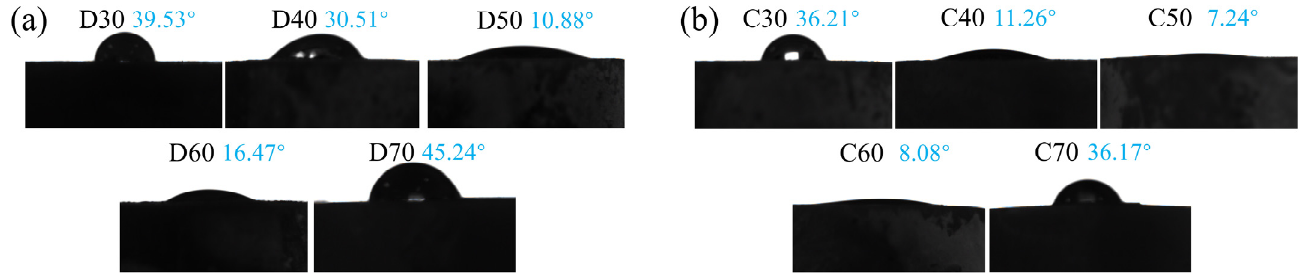
Figure 13. Water contact angles of ( a ) the deposition products (D30 − D70) and ( b ) the calcination products (C30 − C70).